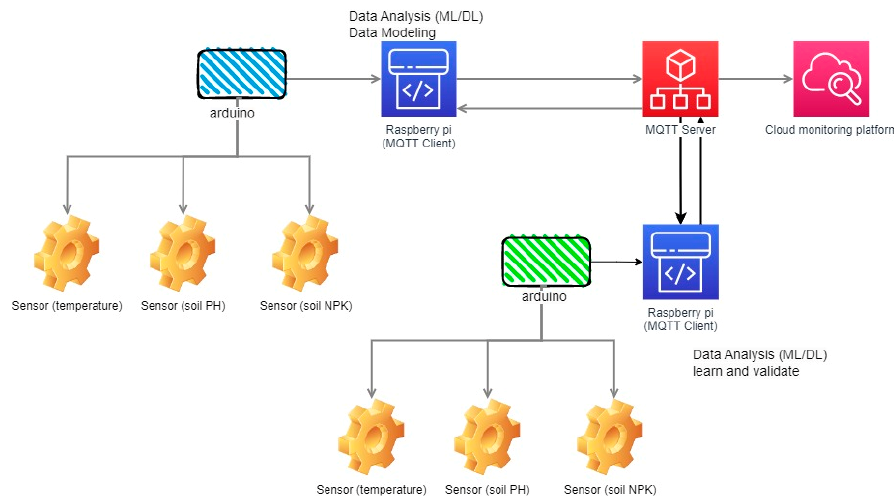
Figure 2. Data collection and training model.